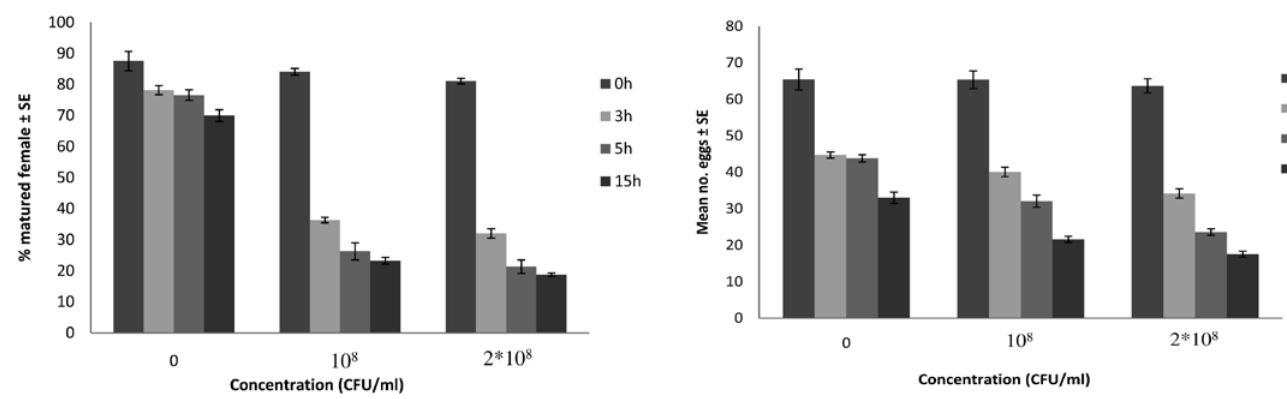
Fig. 3 - Effect of root soaking duration in bacterial suspension on mean number of eggs of